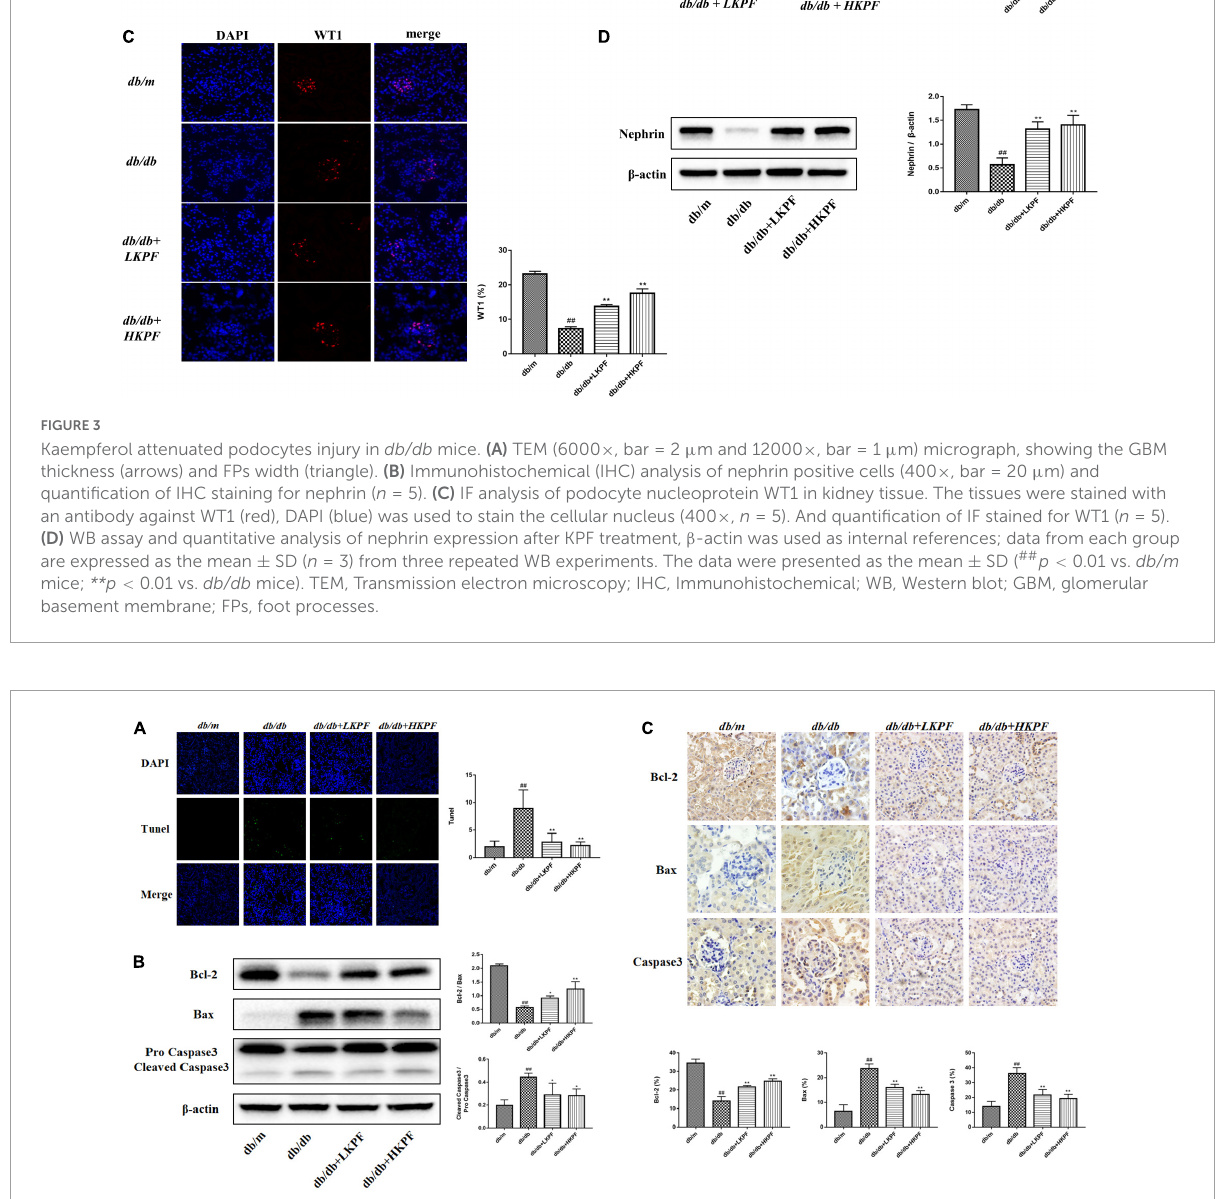
FIGURE4 Kaempferol reduced apoptosis in the kidneys of db/db mice. (A) TUNEL-positive cells (green) were stained in glomeruli after Kaempferol treatment, DAPI (blue) was used to stain the cellular nucleus (400 × , n = 3). (B) WB assay and quantitative analysis of apoptosis-related proteins Bcl-2, Bax, and Caspase 3 expressions after Kaempferol treatment, β -actin was used as internal references; data from each group were expressed as the mean ± SD ( n = 3) from three repeated WB experiments. (C) IHC assay and quantitative analysis of apoptosis-related proteins: Bcl-2, Bax, and Caspase 3 (400 × , n = 5). ( ## p < 0.01 vs. db/m mice; *p < 0.05 and **p < 0.01 vs. db/db mice). IHC, Immunohistochemical; WB, Western